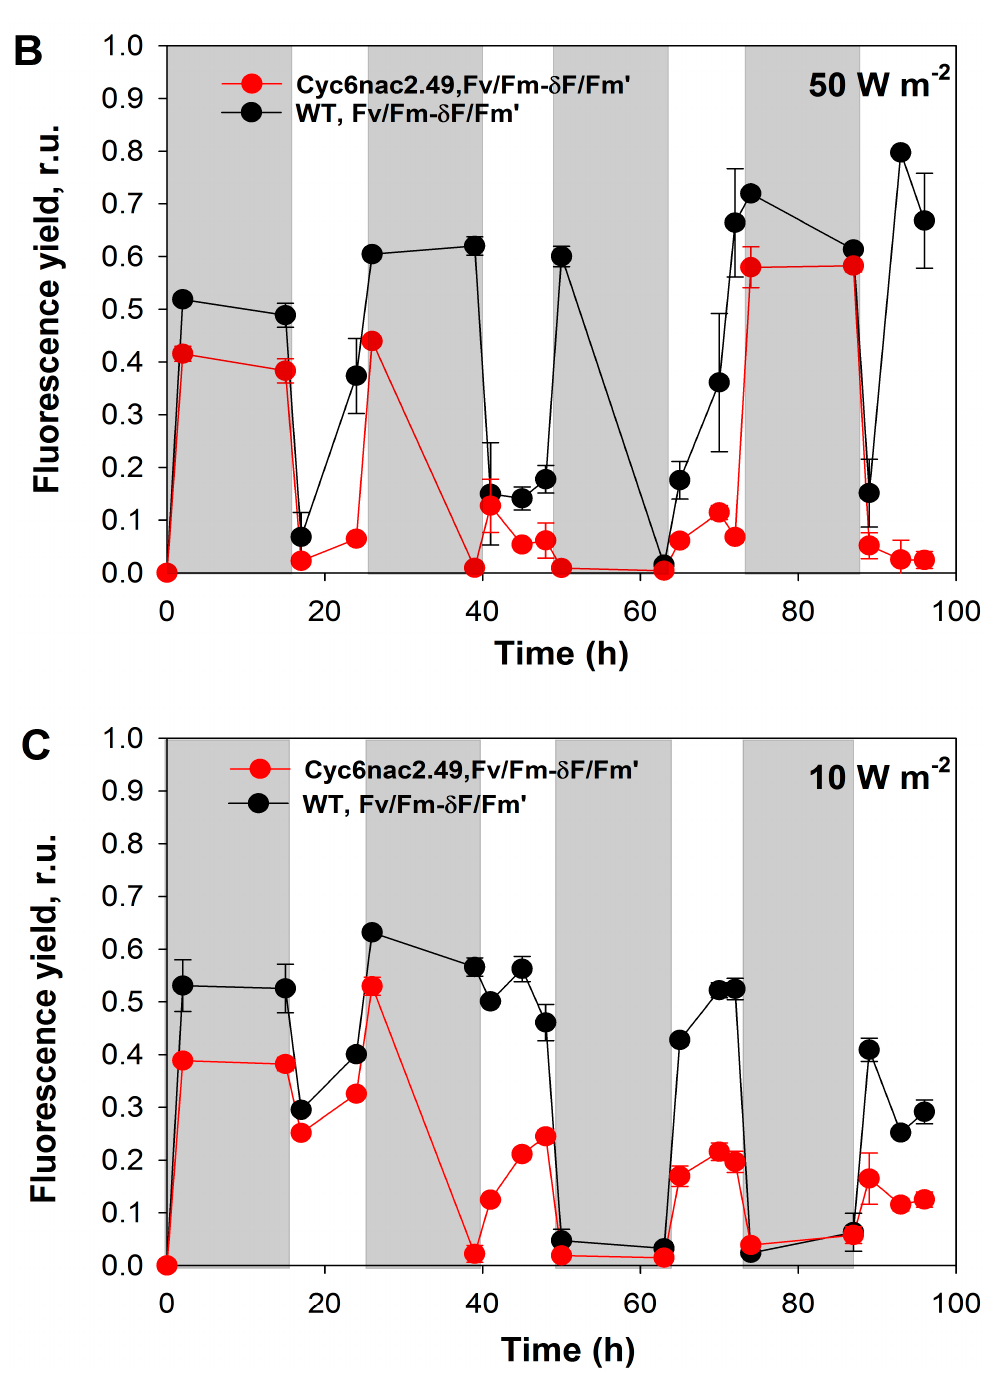
Figure 3. ( A ) H 2 and O 2 production of C. reinhardtii strain cy6Nac2.49 (red) and it is parental wild-type (black) under photoheterotrophic conditions on TAP medium under a light/dark regime at light intensities of 50 W·m − 2 and 10 W·m − 2 . Cultures were left under an air atmosphere in sealed vials at the start of the experiment and were not sparged with argon during the experiment. The maximum photosynthetic yields were measured at different light intensities ( B ) 50 W·m − 2 and ( C ) 10 W·m − 2 respectively, where Fv/Fm represents the maximum fluorescence emission recorded in the dark periods, while δ Fv/Fm’ represents the maximum fluorescence value recorded during illumination. Shaded and not shaded sections represent dark (14 h) and light (10 h) periods respectively.